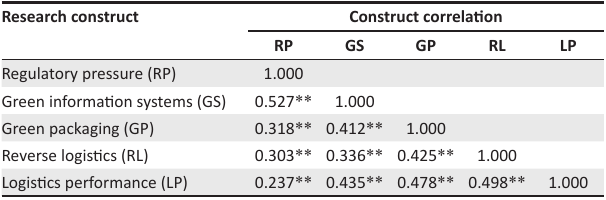
TABLE 2: Interconstruct